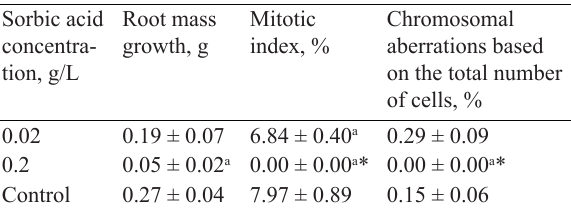
Table 2 Inhibition of the root mass growth and the mitotic index after treatment with sorbic acid (n = 9) Sorbic acid concentra- tion, g/L